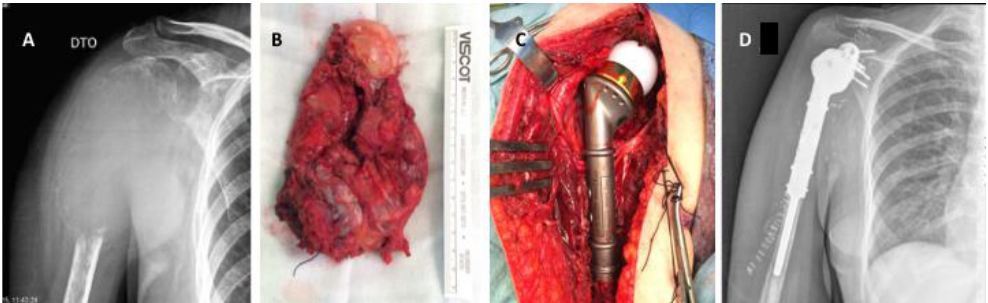
Figure 6. Shoulder megaprosthesis in a solitary kidney cancer metastasis in the proximal humerus: ( A ) preoperative image showing the right humerus with an extensive osteolytic lesion and pathologic fracture secondary to kidney carcinoma. An important soft tissue component is visible. ( B ) Tumor specimen after en bloc resection, ( C ) intraoperative image showing the tumoral megaprosthesis in place, ( D ) immediate postoperative anteroposterior radiograph.